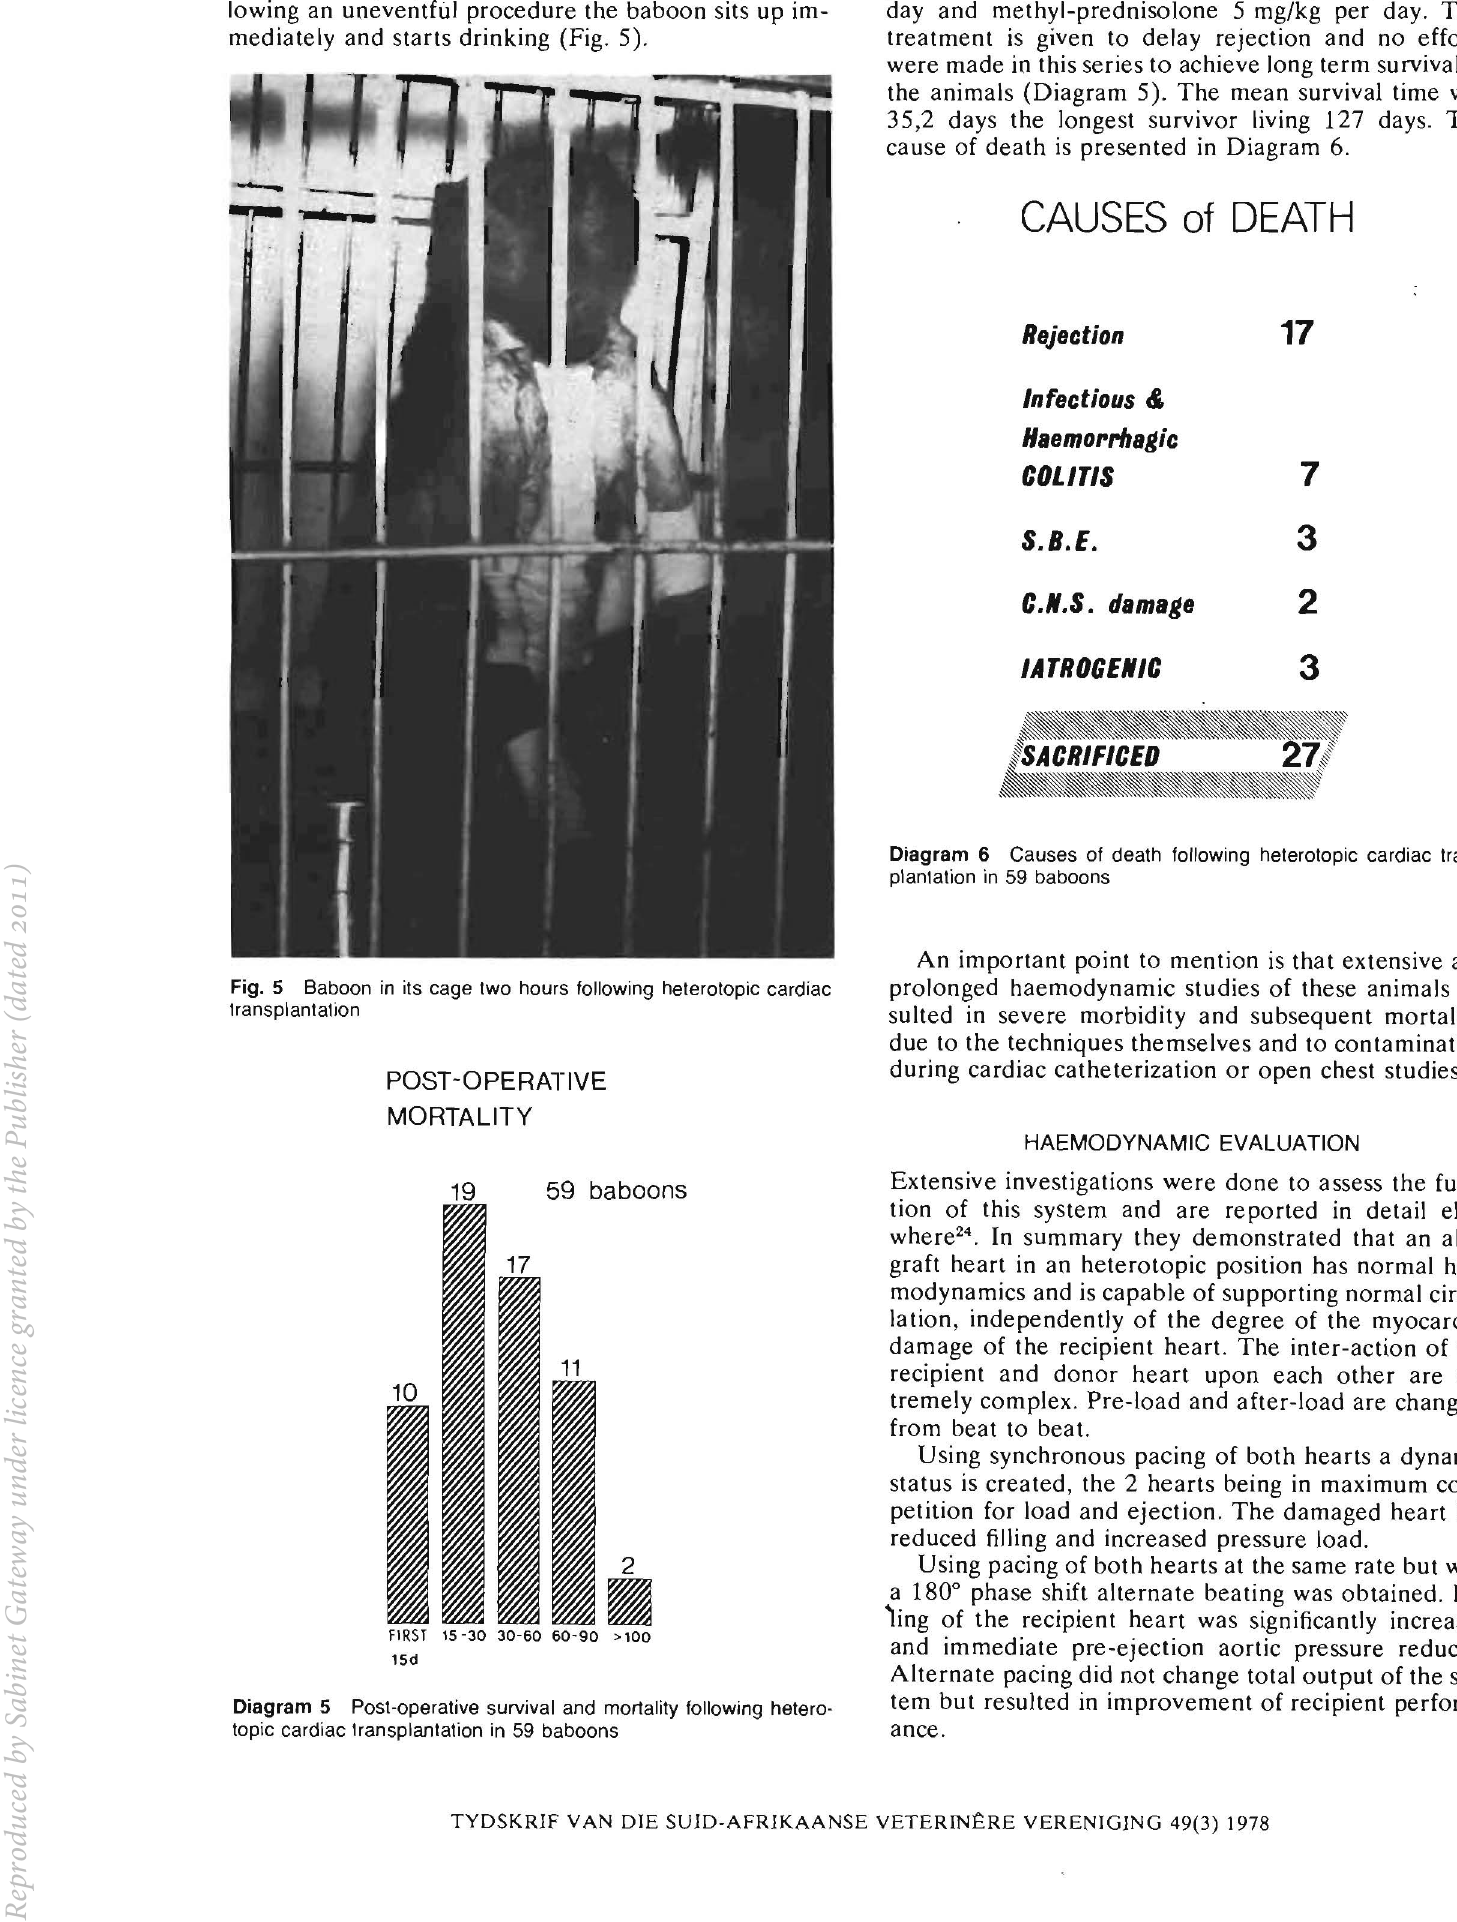
Fig. 5 Baboon in its cage two hours following heterotopic cardiac transplantation